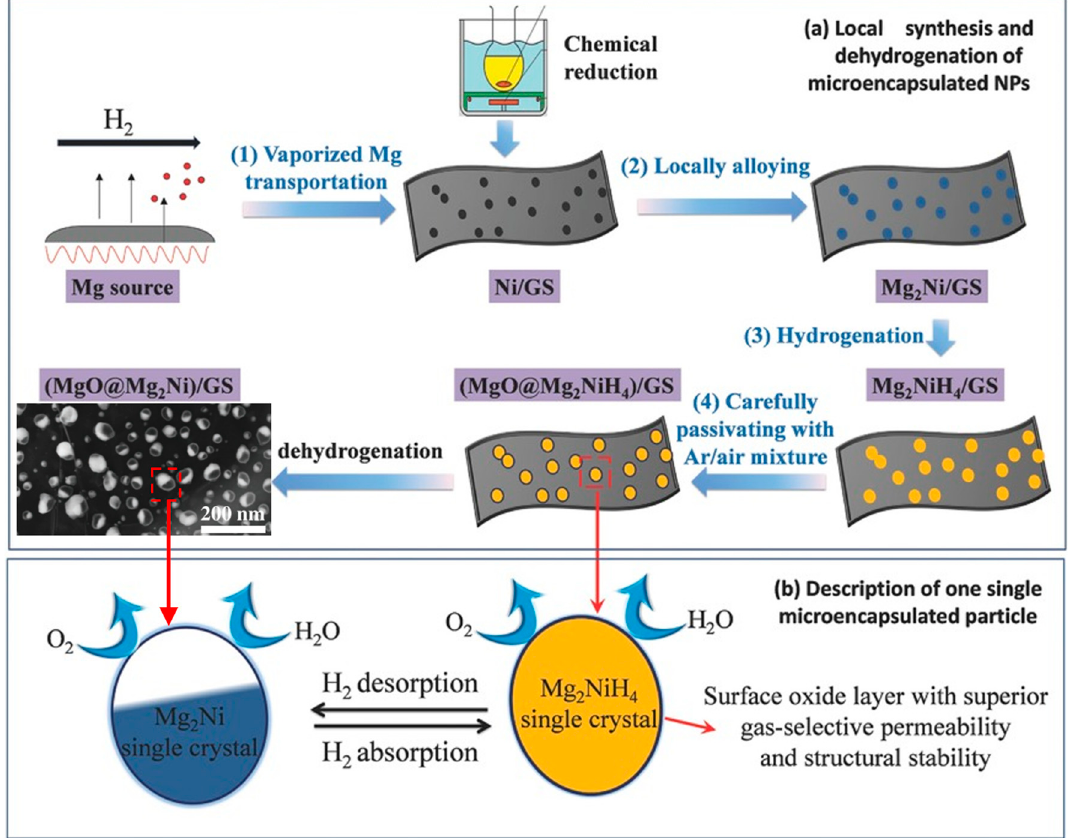
Figure 9 . ( a ) Schematic of the local synthesis of Mg 2 NiH 4 NPs derived from Ni/GS (graphene sheet) by hydriding chemical vapor deposition (HCVD). Mg vapors are transported under H 2 atmosphere to the Ni / GS substrate, where they alloy with Ni forming Mg 2 Ni NPs. Subsequent hydrogenation and passivation lead to Mg 2 NiH 4 NPs surrounded by an MgO shell. After H desorption, a semi-hollow core is left, as clearly shown by the scanning electron microscopy image in the bottom left corner. ( b ) The MgO shell is permeable to hydrogen but not to oxygen and water. Reprinted with permissions from [99] (copyright 2017 Wiley-VCH).